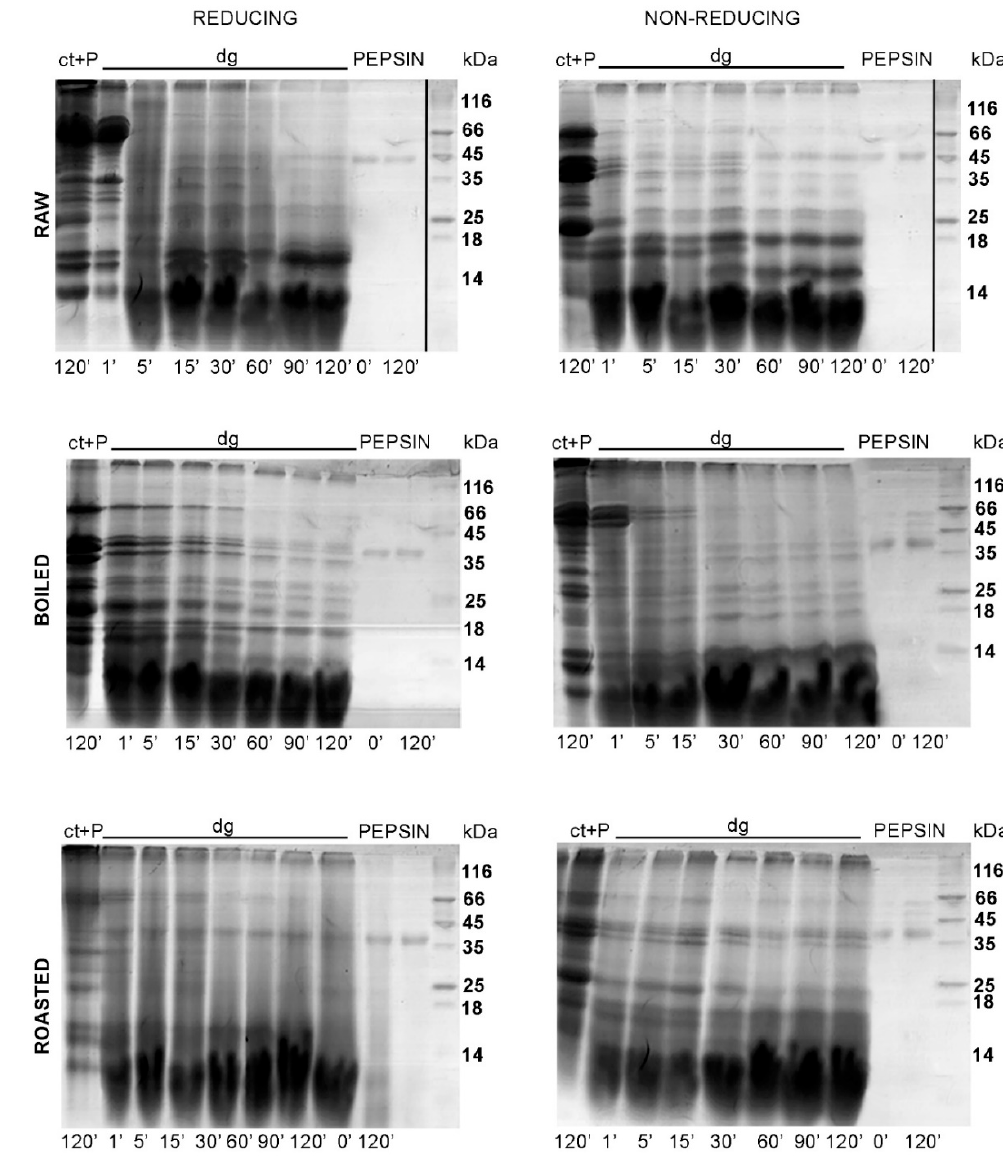
Figure 5. SDS-PAGE protein profiles after the TCA/acetone defatting of raw, boiled, and roasted peanuts digested in conditions mimicking gastric digestion at different time points. SDS-PAGE was performed in reducing and non-reducing conditions on 14% gels. ct + P—control at 120 min containing pepsin; dg—digest at 120 min; PEPSIN—controls containing only pepsin; M—molecular weight markers. The different time points are indicated below the gels.